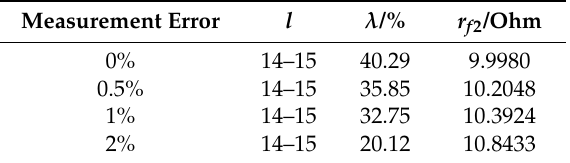
Table 18. Locating results of Strategy 1 with different measurement errors for Case